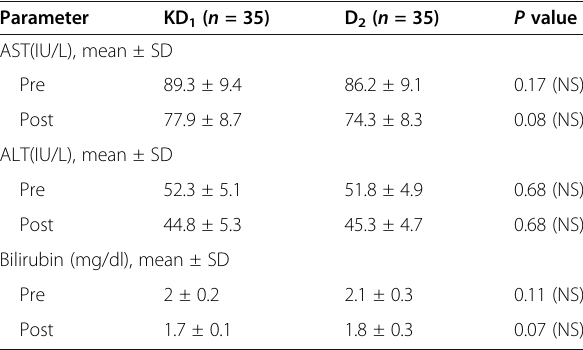
Table 5 Changes in parameters of liver functions (AST, ALT, and serum bilirubin) between before and 3 days after the procedure in the two studied groups Parameter KD 1 ( n =